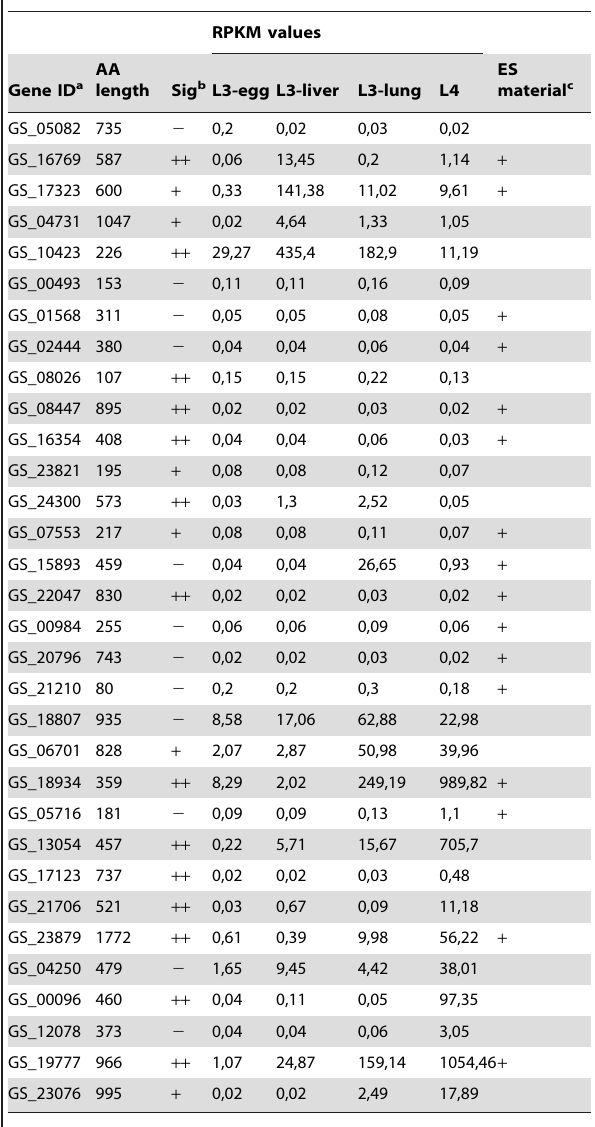
Table 4. List of glycosyl hydrolases identified in the A. suum genome, their sequence length and their gene levels in different larval